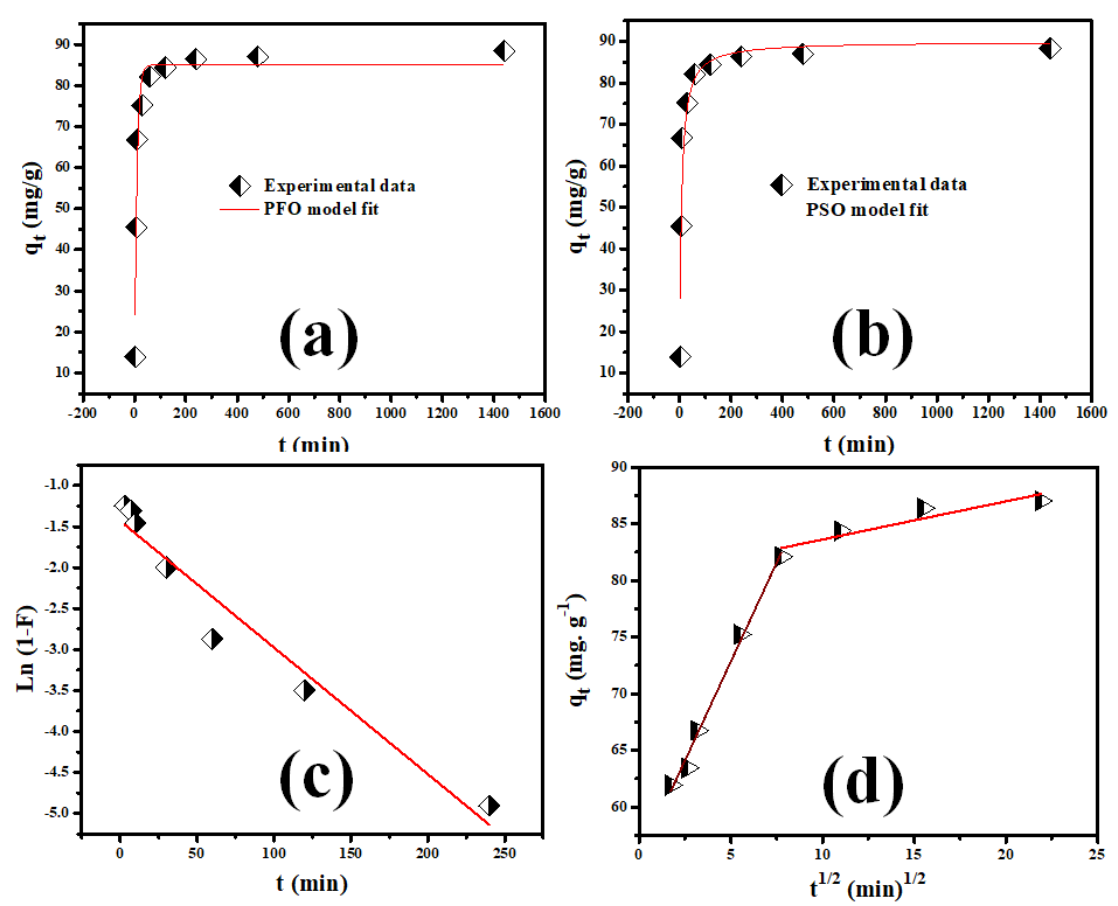
Figure 7. ( a , b ) The PSFO and PSSO sorption rate order investigations for Rh-B sorption on the